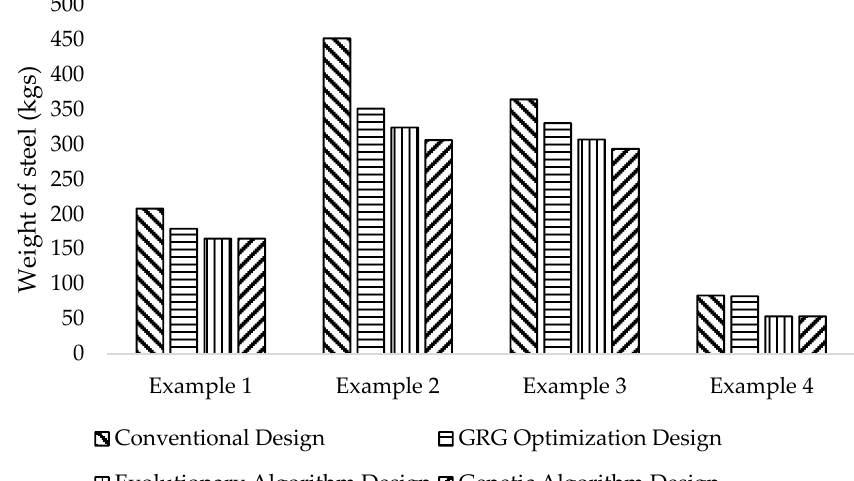
Figure 9. Comparison of concrete volume for examples 1–4.